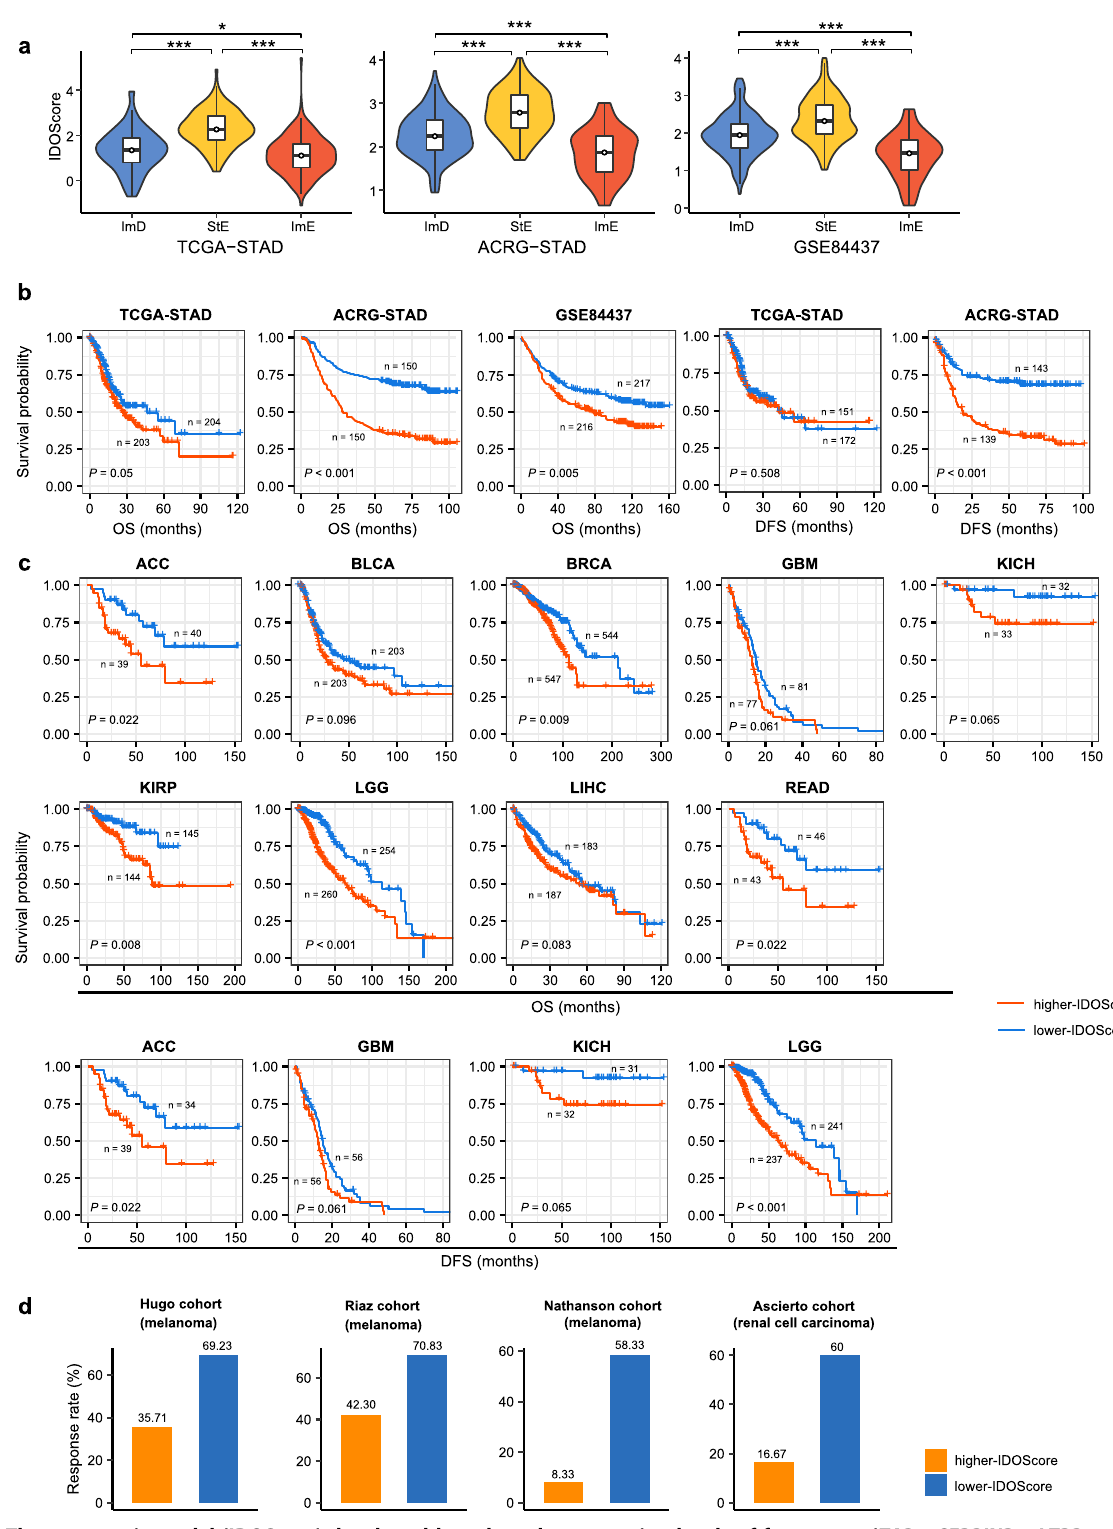
Fig. 11 The prognostic model (IDOScore) developed based on the expression levels of four genes ( TAP2 , SERPINB5 , LTBP1 , and LAMC1 ) involved in immune, DNA damage repair, oncogenic, and stromal pathways. a Comparisons of the IDOScore values between the three GC subtypes. The one-tailed Mann – Whitney U test P values are indicated. Kaplan – Meier curves showing that the IDOScore is inversely correlated with survival prognosis in GC ( b ) and nine other cancer cohorts in TCGA ( c ) (log-rank test, P < 0.1). d Lower-IDOScore (< median) cancers showing signi fi cantly higher response rates than higher-IDOScore (>median) cancers in four cancer cohorts receiving immune checkpoint inhibitor treatment. ACC adrenocortical carcinoma, BLCA bladder urothelial carcinoma, BRCA breast invasive carcinoma, GBM glioblastoma multiforme, KICH kidney chromophobe, KIRP kidney renal papillary cell carcinoma, LGG brain lower grade glioma, LIHC liver hepatocellular carcinoma, READ rectum adenocarcinoma. * P < 0.05, ** P < 0.01, *** P <